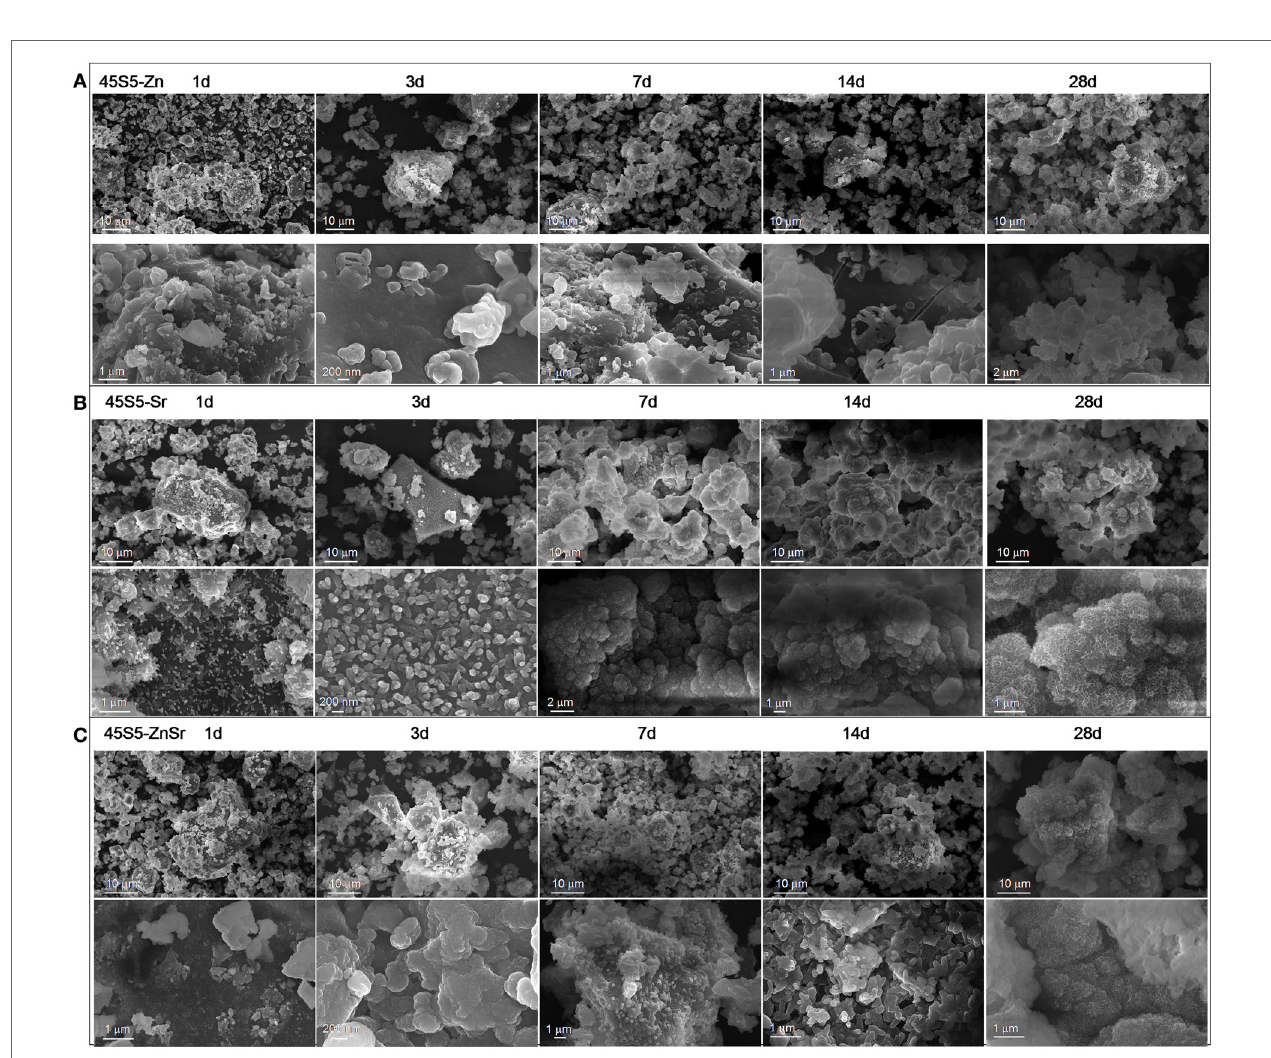
FigUre 3 | seM micrographs of 45s5-Zn (a), 45s5-sr (B), and 45s5-Znsr (c) after different times of immersion in sBF